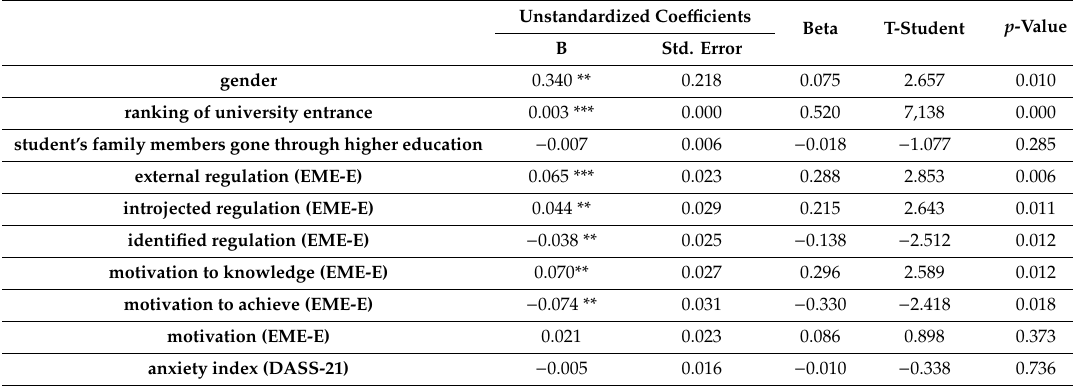
Table 2. Estimation result academic performance using two-stage least square